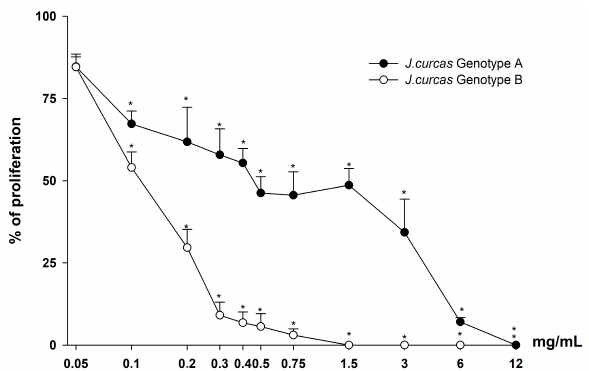
Figure 7. E ff ect of J. curcas extracts of JA and JB on proliferation of Bu ff alo normal rat liver cell line (BRL-3A) cells measured by MTT test, after 24 h treatment. Data represent the mean ( ± SE) of two independent experiments done in triplicate. * p < 0.05 vs. control (Dunnett’s